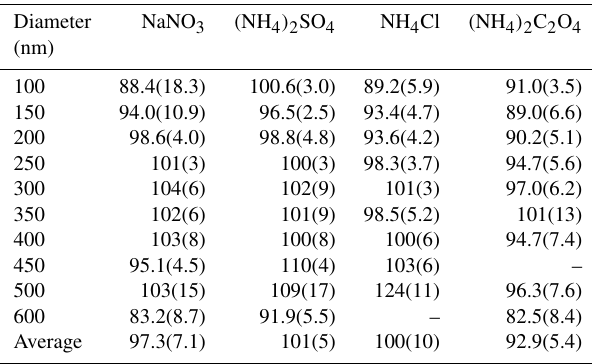
Table 2. Particle conversion efficiencies (%) with uncertainties (1 standard deviation) in parentheses. The sizing accuracy is ∼± 2.5% using NIST-traceable PSLs for 150–500nm spheres as our calibration